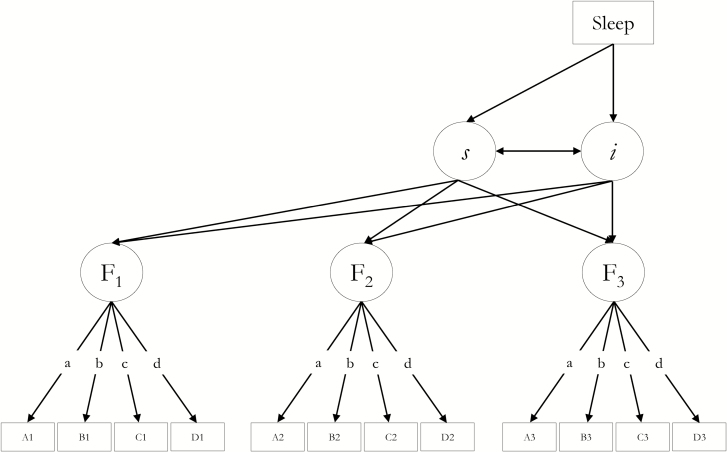
A schematic latent growth curve model, in which self-reported sleep is associated with the intercept and linear slope of a latent factor of cognitive function (F) at wave j based on test scores Aj, Bj …, whose intercepts, and factor loadings (a–d) on the latent cognitive factor are constrained to equality across the three waves. Residual correlations between the same tests across waves were allowed, and manifest cognitive variables were corrected for sex and mean-centered agej within the model (paths not shown—see Statistical Analysis). The model was centered on wave 3 (age 76) when sleep data were collected. The regressions of Sleep (predictor) on cognitive intercept (i) and slope (s) were the associations of interest.